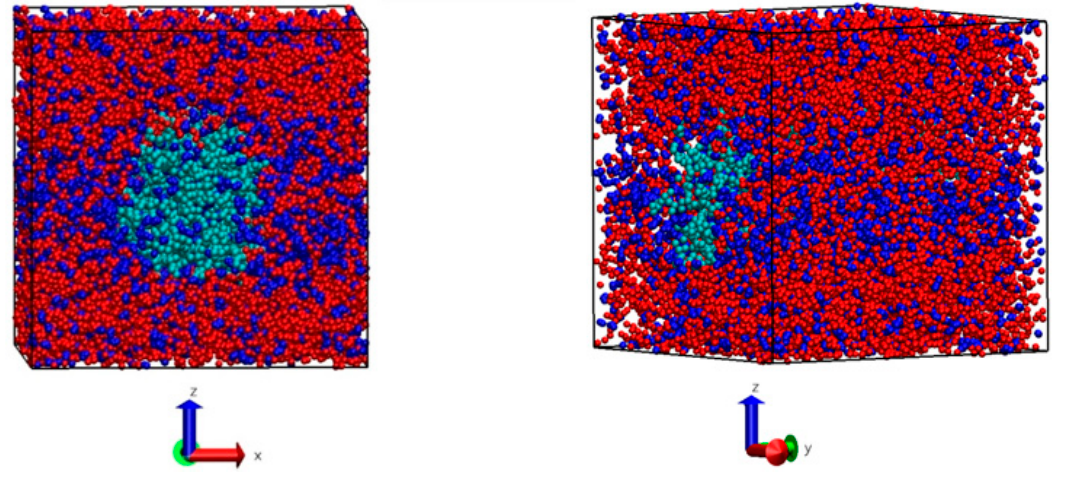
Figure 6. Cellulose fiber (green) solvated with IL (red) and water (blue).